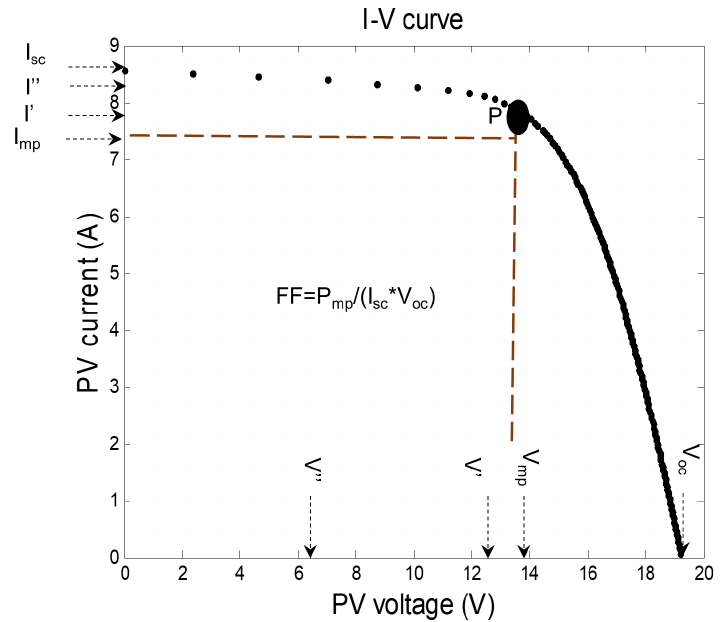
Figure 7. Example of extracted features from an I–V curve.